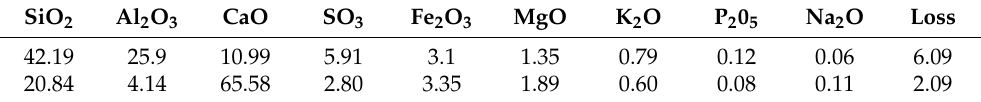
Figure 1. Digital images: ( a ) raw desulfurization slag; ( b ) ground desulfurization slag. Table 1. Main chemical composition of ground desulfurization slag and PC (%).